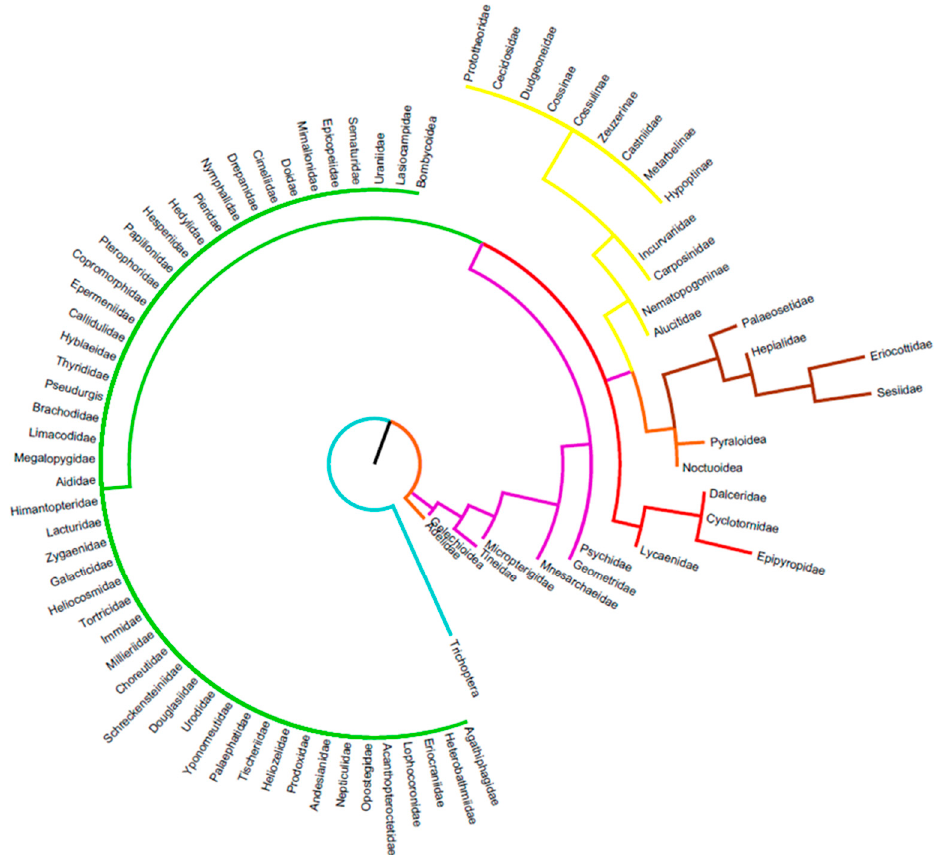
Figure 3. Caterpillars; cladistic classification (see material and methods for parameters) and group- ing of subdivisions of the phylogeny of [37] according to the occupation of various living environ- ments. Green: leaf use, yellow: stems or wood, orange: litter, purple: fungi, brown: soil, red: carnivores, and blue: freshwater.